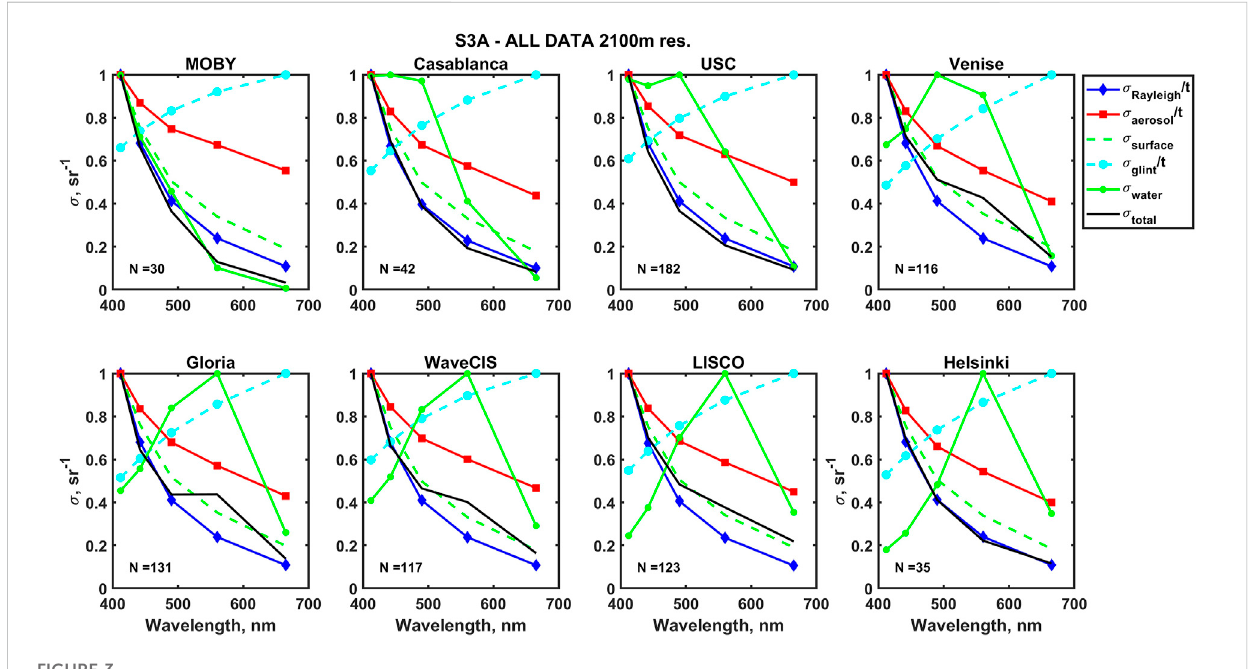
FIGURE 3 Normalized spectra for all sites (7 × 7 pixels, 2,100 m resolution), OLCI S3A.